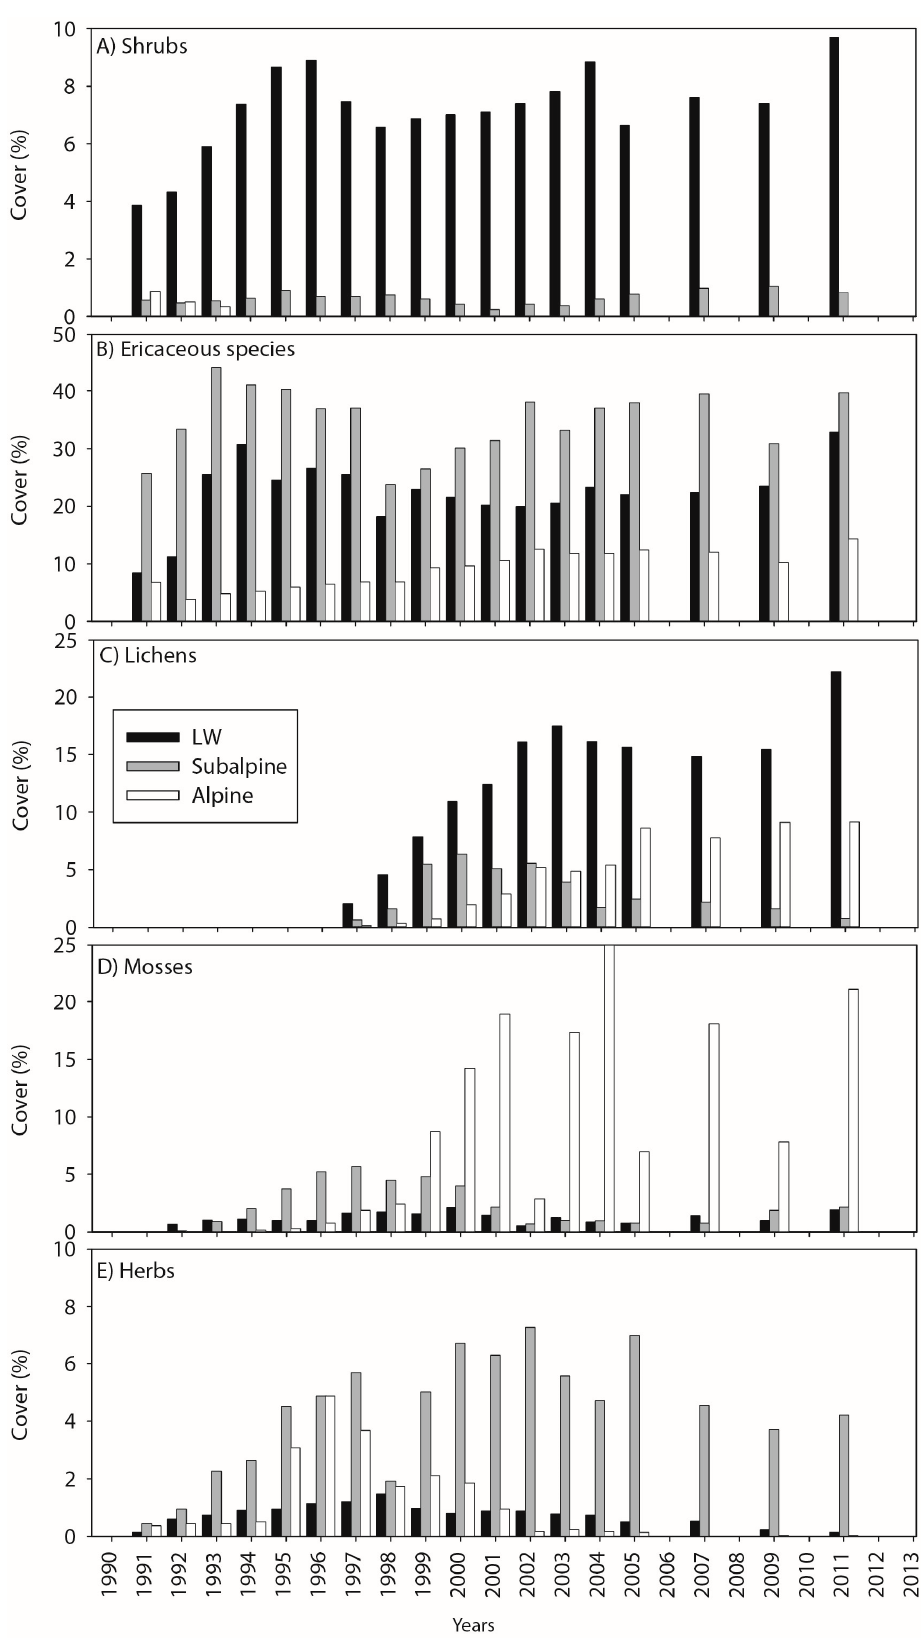
Figure 3. Total cover of shrubs ( A ), ericaceous species ( B ), lichens ( C ), mosses ( D ) and herbs ( E ) in lichen woodland (LW, black), subalpine (grey) and alpine (white) sites along the postfire chronosequence.3.2. PCA Analysis.